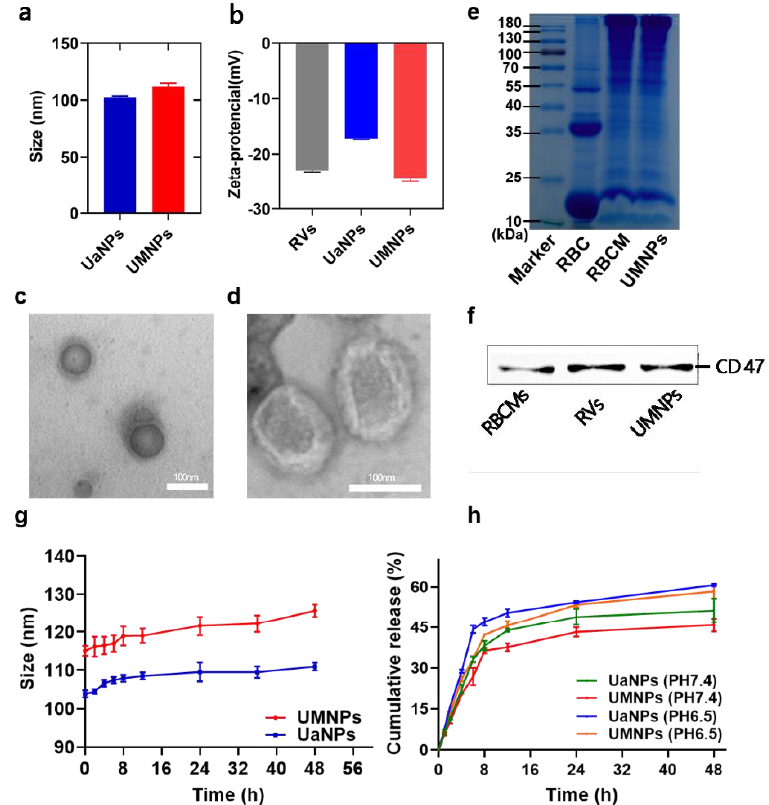
Figure 1. Characterization of NDDS. ( a , b ) Particle size and zeta potential of UaNPs and UMNPs, respectively; ( c , d ) TEM images of UaNPs and UMNPs, respectively. Scale bar = 100 nm; ( e ) Total protein verification in RBC, RBCMs, and UMNPs by SDS-PAGE; ( f ) Western blot analysis of RBCMs and UMNPs for characteristic RBCM marker CD47; ( g ) Particle size changes of UMNPs in 10% FBS within 48 h; and ( h ) Release curve of UaNPs and UMNPs in vitro in PBS (pH 7.4 and 6.5). Data presented as mean ± SD ( n = 3).